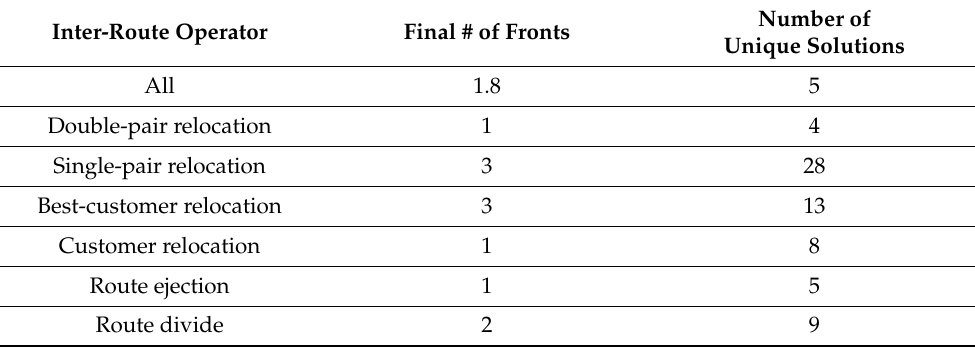
Table 8. Inter-route operation effects on diversity of bar-n100-5 [29].